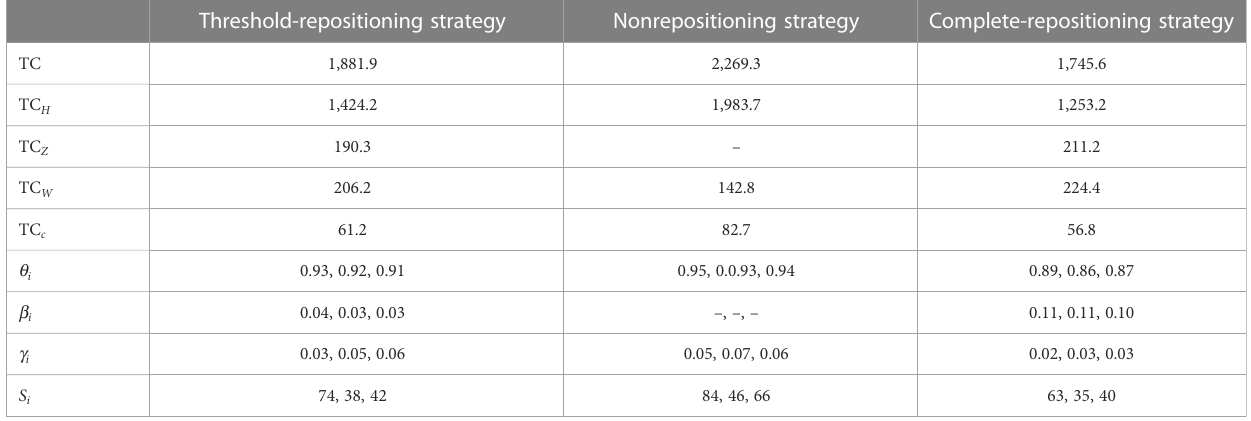
TABLE 3 Results from two strategies.